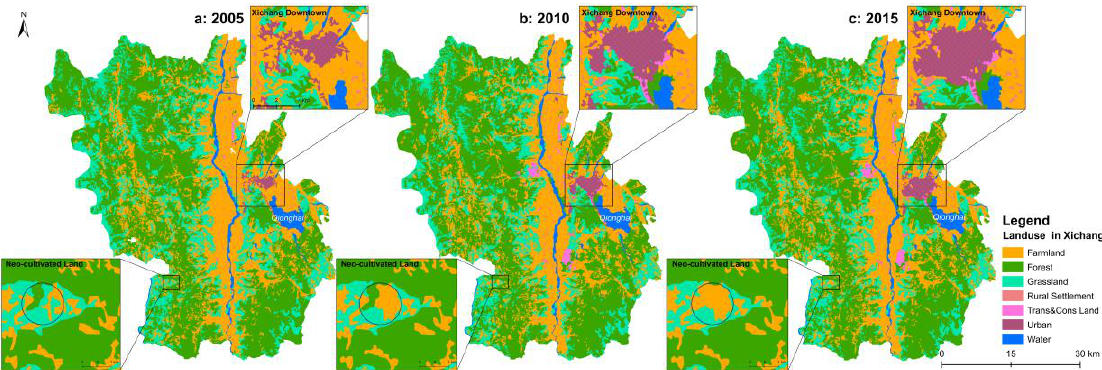
Figure 3. Urban Expansion and Farmland Reclamation in Xichang (2005 – 2015). Agriculture 2019 , 9 , x FOR PEER REVIEW